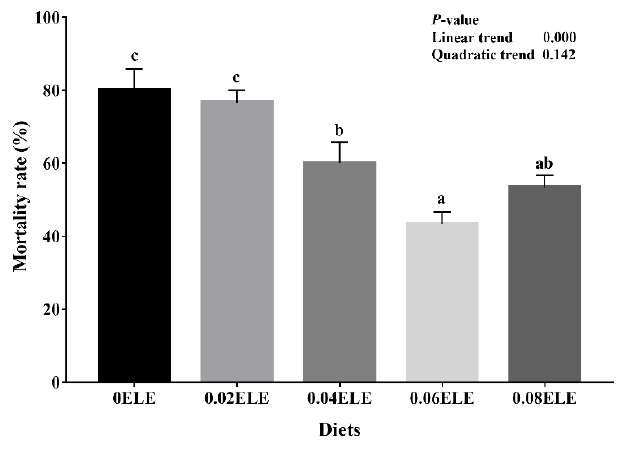
Figure 6. Mortality rate of GIFTs fed with different ELE levels with Streptococcus agalactiae challenge after 144 h. Data are expressed as means ± S.E.M., value with different letters (a, b, c) are significantly different ( p < 0.05).